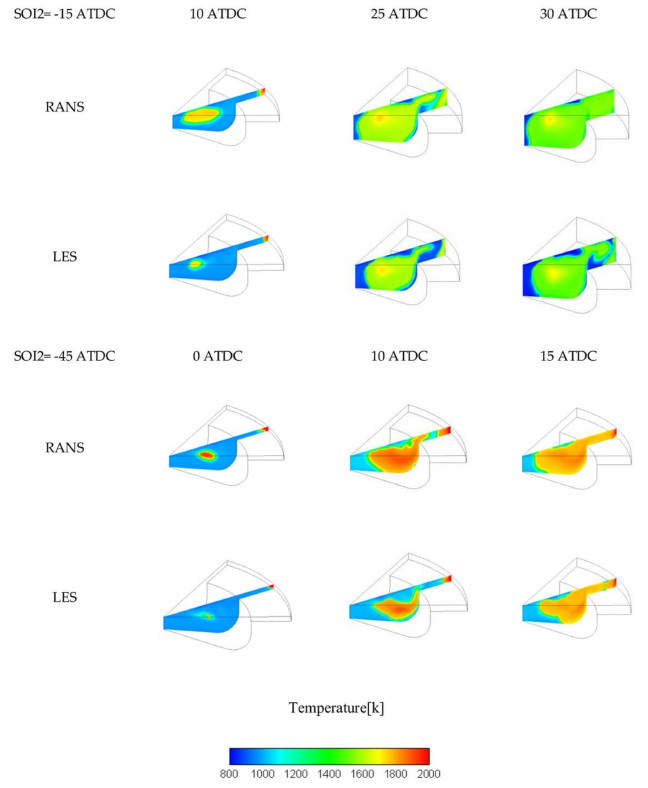
Figure 9. Comparison of LES and RANS model for cylinder temperature cut planes at 3 crank angles for SOI2 = − 15 TDC and SOI2 = − 45